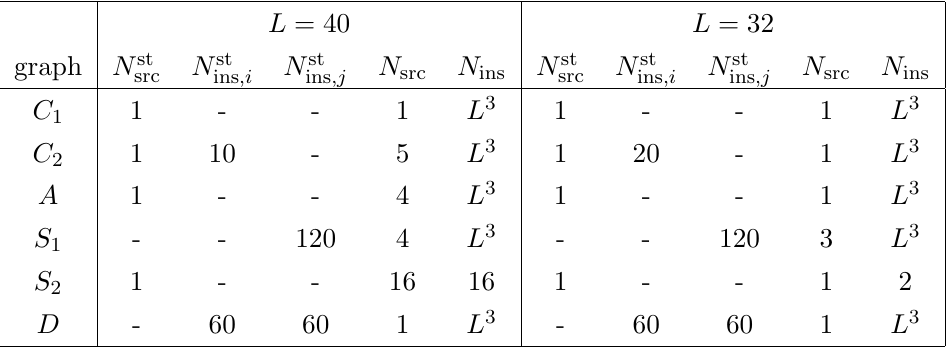
Table 2. Numbers N st of stochastic noise vectors and numbers of sources and current insertions used for each graph in our simulations for the two lattice volumes. For most graphs, stochastic propagators are connected to the insertion, which implies an average over the entire spatial lattice volume. This is indicated by N ins = L 3